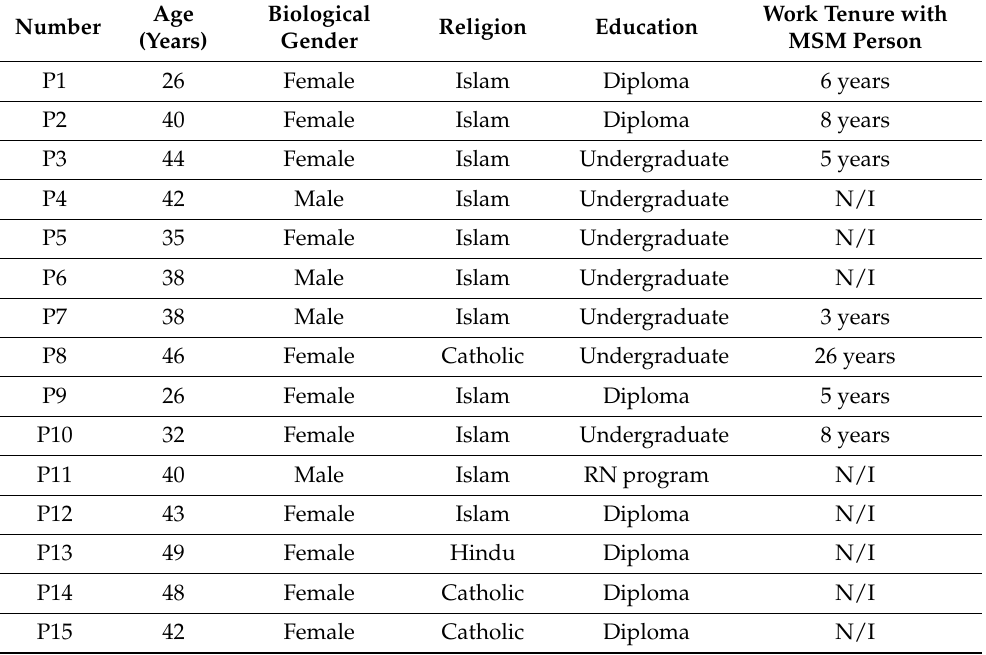
Table 1. Characteristics of